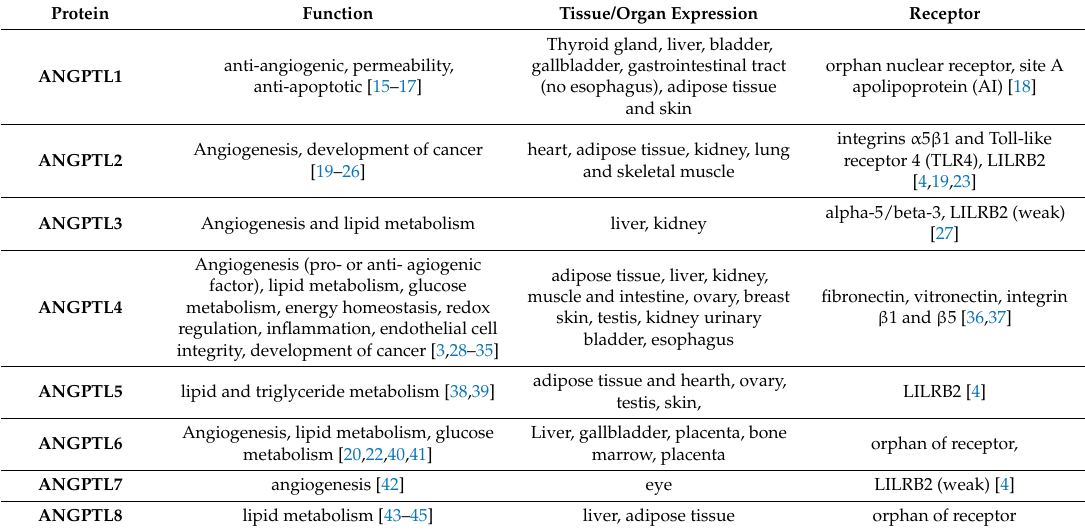
Table 1. ANGPTL proteins characteristics and main